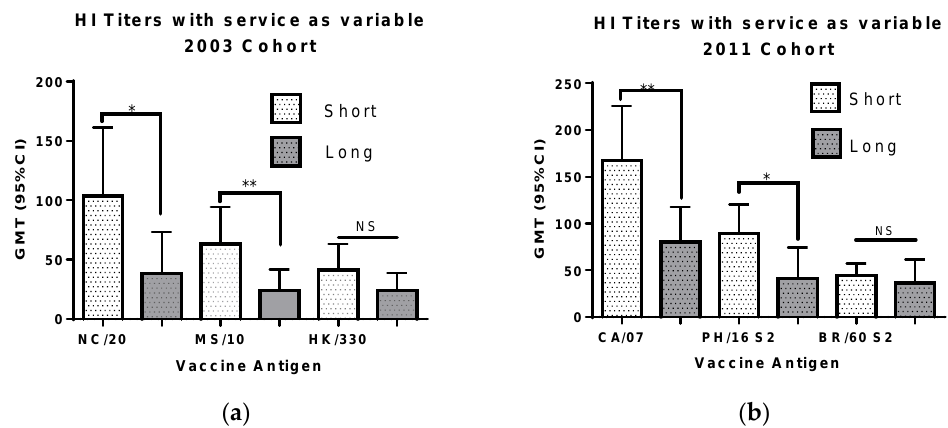
Figure 3. The geometric mean titers (with 95% confidence interval) for sera from personnel with short and long service are shown. The data for ( a ), the 2003 cohort, are from 48 subjects with 1–2 years of service and 19 subjects with 8–9 years of service. The data for ( b ), the 2011 cohort, are from 63 subjects with 1–2 years of service and 23 subjects with 8–9 years of service. The viruses used for testing HI titer are listed on the x axis: NC/20, A/New Caledonia/20/1999 (H1N1); MS/10, A/Moscow/10/1999 (H3N2); HK/330, B/Hong Kong/330/2001 (Victoria lineage); CA/7, A/California/07/2009 (pdmH1N1); PH/16, A/Perth/16/2009 (H3N2); and BR/60, B/Brisbane/60/2008 (Victoria lineage). The difference between the short and long service groups was evaluated using the Mann Whitney rank test. NS, not significant; *, p < 0.05; and **, p < 0.01.